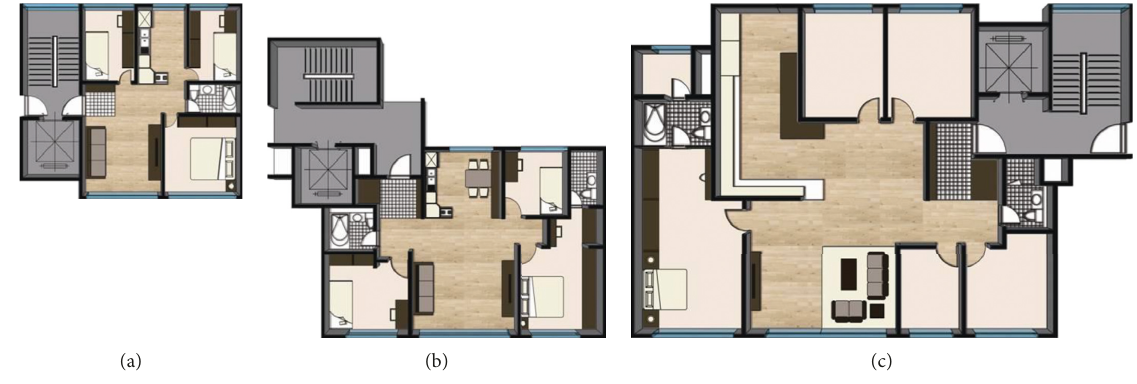
Figure 1: Concept of BAY in South Korea. (a) 2 BAY, (b) 3 BAY, and (c) 4